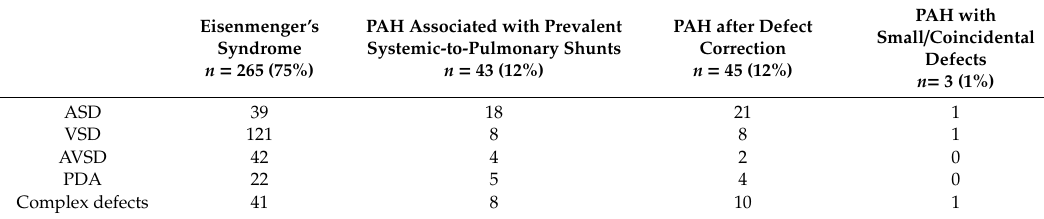
Table 2. The prevalence of di ff erent heart defects in four subgroups of patients according to the European Society of Cardiology.